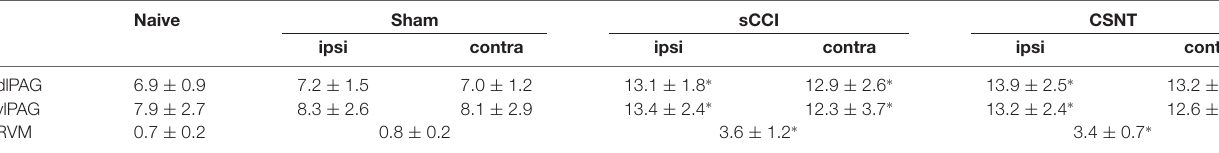
TABLE 3 | Percentage of OX-42+ area ± SD in RVM and dorsolateral (dl) and ventrolateral (vl) PAG of naïve rats as well as in dlPAG and vlPAG of ipsilateral (ipsi) and contralateral (contra) sides from sham-operated rats and rats with sCCI and CSNT for 3 weeks. Naive Sham